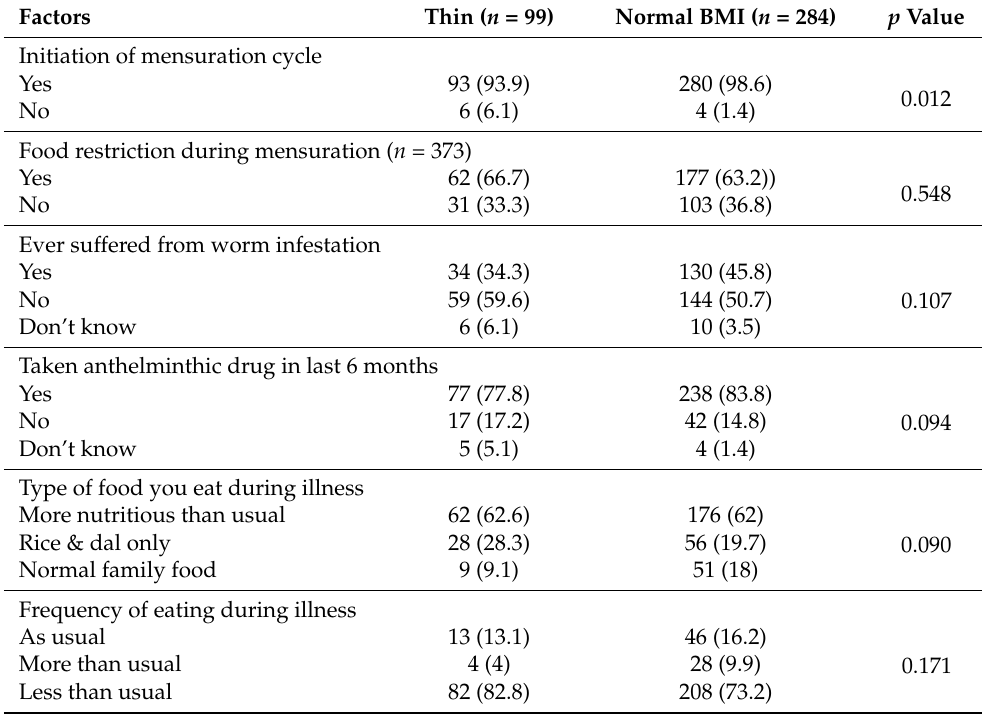
Table 4. Disease and mensuration and related practices for thin and normal BMI